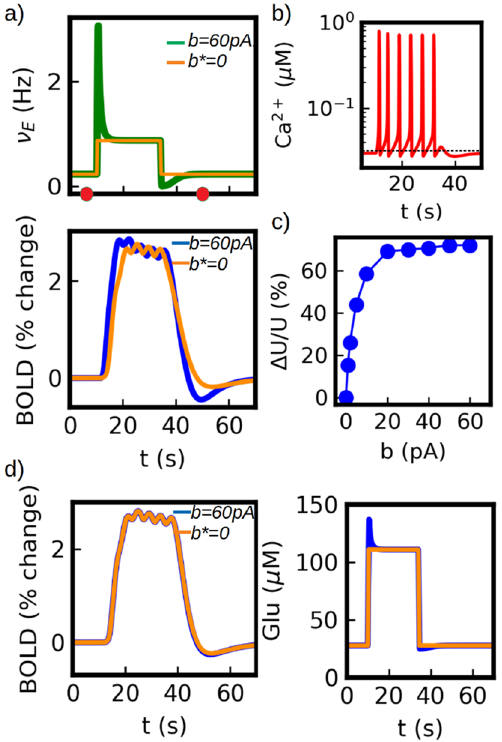
Figure 7. Neuronal adaptation effects in BOLD signal. ( a ) Top: neuronal activity during stimulus application with (green) and without (orange) adaptation (for a better comparison, we re-scale the asymptotic firing rate for b = 0 to match the one of b = 60 pA, so we indicate it with b ∗ ). Bottom: BOLD response with (blue) and without (orange) adaptation. The effects of adaptation can be observed in the higher initial response for the blue curve and in the larger post-stimulus undershoot. The simulations correspond to t w =5s. ( b ) Calcium-spike adaptation. The frequency and amplitude of the calcium-spikes are modulated by the changes of glutamate concentration due to neuronal adaptation. In the figure we can see the adaptation effects occurring during the first three calcium-spikes after which a steady state is reached. In addition, a decrease in the post-stimulus calcium concentration is induced by the neuronal post-stimulus undershoot. The calcium time course shown correspond to the lapse within the red circles indicated in top panel ( a ). ( c ) Adaptation effects in the post- stimulus undershoot (PSU) of the BOLD response. The plot shows the variation in the PSU of the BOLD response as a function of the adaptation constant b (see Eq. 2). The variations in the undershoot are measured as (cid:31) U/U=(min(BOLD)-min(BOLD Ad ))/min(BOLD), where min() indicates the minimum value and BOLD Ad correspond to the BOLD response when neuronal post-stimulus undershoot is removed. In our simulations the undershoot of the neuronal activity is responsible of up to about 70 % of the BOLD PSU for the highest values of b (with t W =5s). ( d ) Simulation results for g r = g ext (equal contribution of external and recurrent activity to glutamate release). We show the BOLD response (left) and glutamate concentration (right). In this case the effects of neuronal adaptation on the BOLD signal are neglectable. The comparison with previous panels ( g ext = 0 ), indicates that information about relative role of recurrent activity can be extracted from the post- stimulus